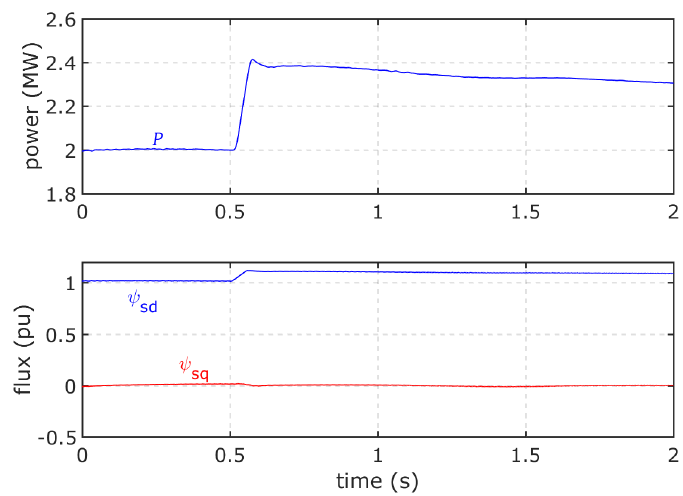
Figure 15. Response to a stator flux step at constant wind speed and load.